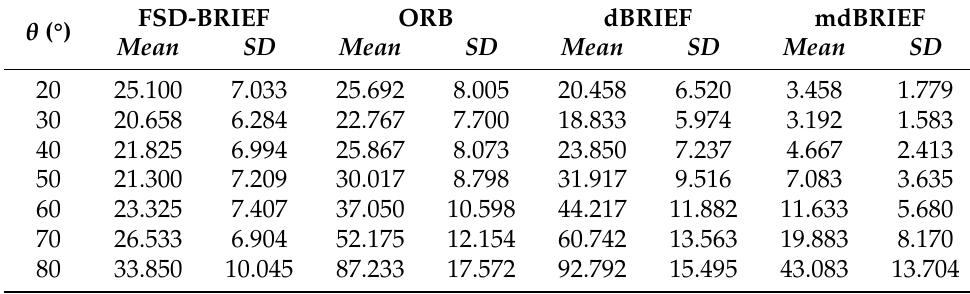
Table 4. The numerical results of Hamming distance error in 170° FoV camera.